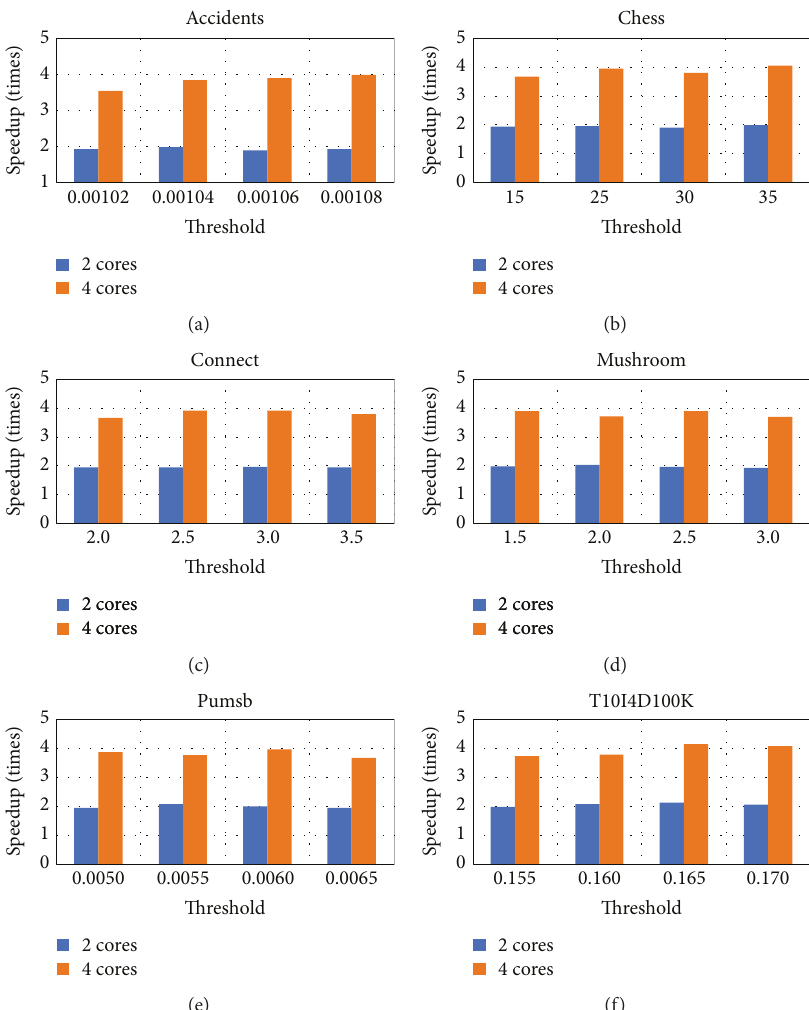
Figure 14: Speedup of the pMEI with the di ff erent numbers of cores on various